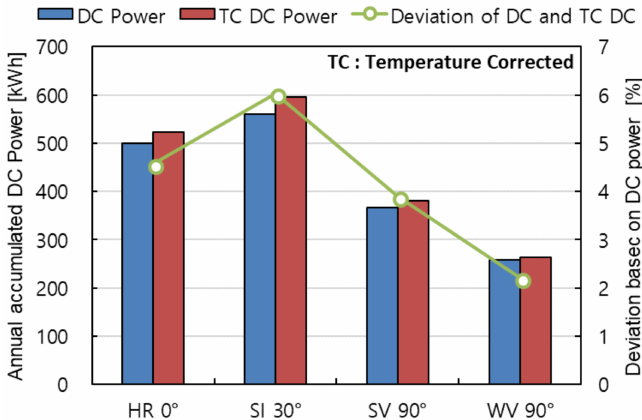
Figure 7. Comparison of the annual accumulated DC power and temperature-corrected DC